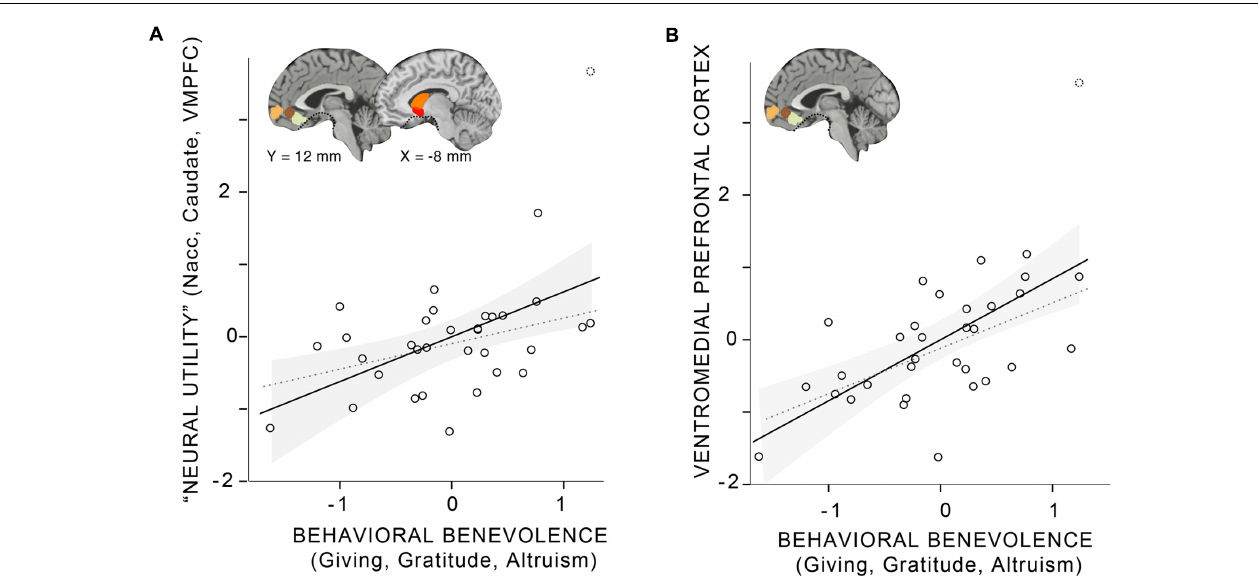
FIGURE 2 | Linear relationship between the behavioral benevolence aggregate and aggregates for neural pure altruism in seven a priori regions of interest (ROIs) implicated in previous research (Hubbard et al., 2016). The insets show the locations of the ROIs: ventromedial prefrontal cortex (VMPFC) ROIs are those reported in Clithero and Rangel (2014). Subcortical ROIs [left and right nucleus accuments (Nacc), left and right Caudate] are Harvard Oxford atlas locations thresholded at 30%. The dashed line in ventral regions of the brain shows the limit of our sampling of the brain due to magnetic susceptibility artifacts. (A) The “neural utility” aggregate that includes all seven ROIs. (B) The aggregate across VMPFC ROI. For both panels, the shaded gray area represents the 95% confidence interval of the mean. The solid line represents the linear estimate with all participants included. The gray dashed line represents the estimate without a participant that was a potential outlier ( > 3 SDs from the mean).